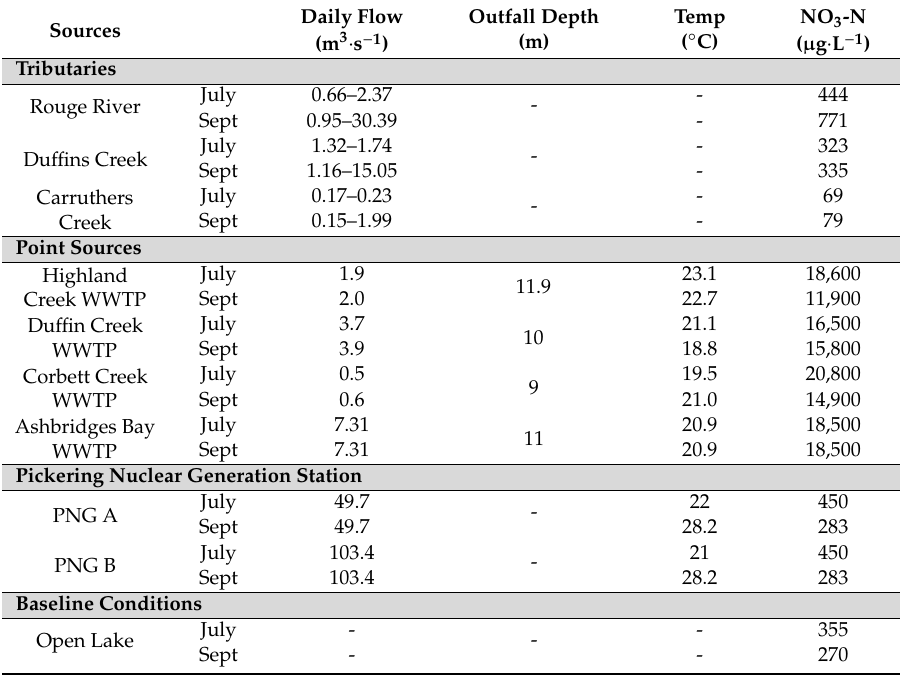
Table 2. Model inputs and environmental forcing conditions used in Finite Volume Community Ocean Model (FVCOM) simulations. Data sources as described in